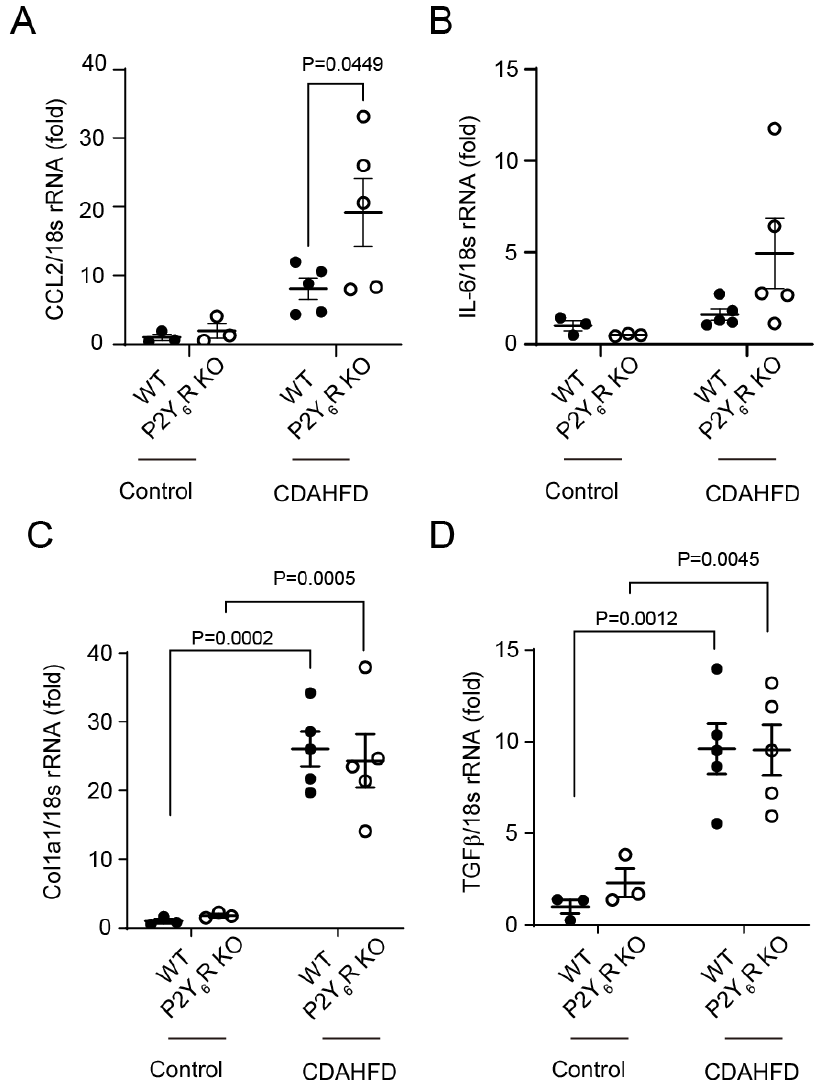
Figure 5. Knockout of P2Y 6 R accelerated expression of liver inflammation markers induced by CDAHFD feeding. Expression of CCL2 ( A ), IL-6 ( B ), Col1a1 ( C ), and TGF β ( D ) in liver were quantified by real-time qPCR. Data are shown as the mean ± SEM (control WT: n = 3, control P2Y 6 R KO: n = 3, CDAHFD WT: n = 5, CDAHFD P2Y 6 R KO: n = 5). Two-way ANOVA followed Sidak’s multiple comparison test.